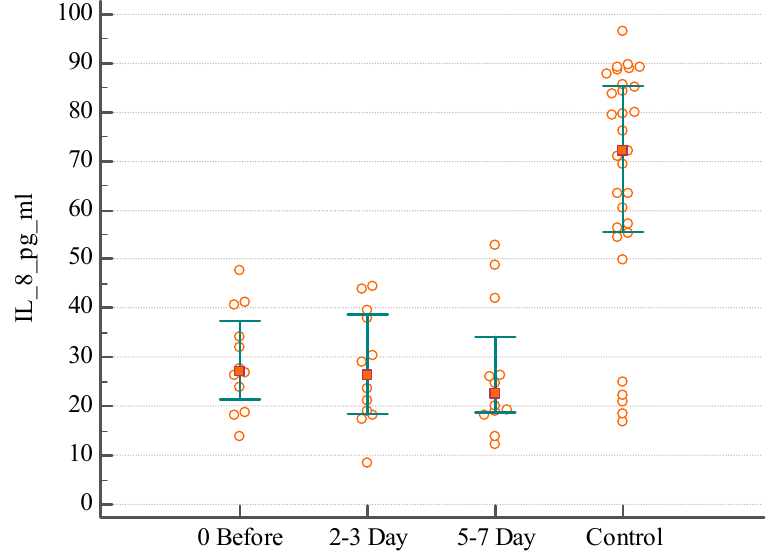
Figure 2. The distribution of serum IL-8 level in patients with primary intra-abdominal abscesses before, and on the 2nd–3rd and 5th–7th days after surgical intervention.